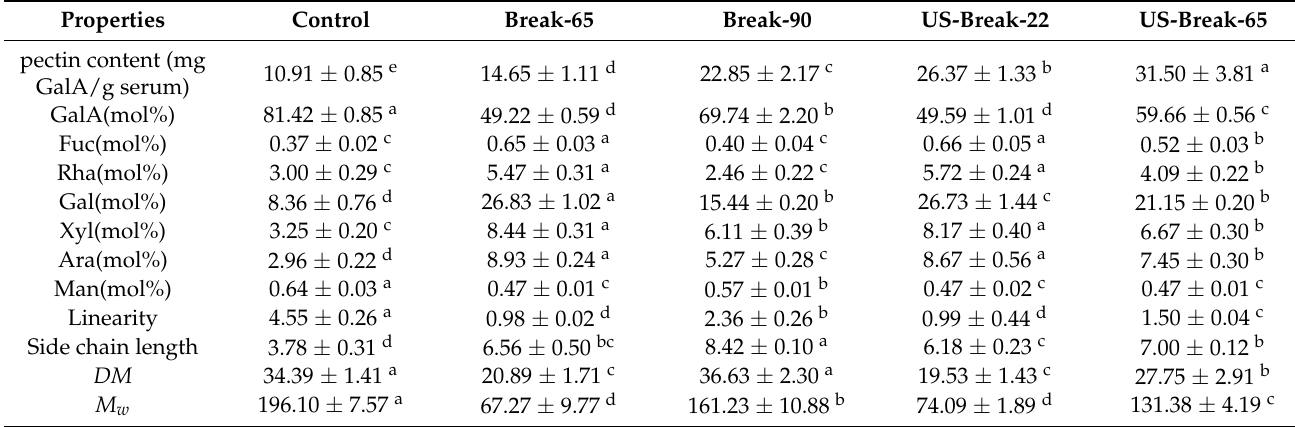
Table 1. Effects of different breaking treatments on the content and physico-chemical properties of the pectin fractions from the serum of tomato